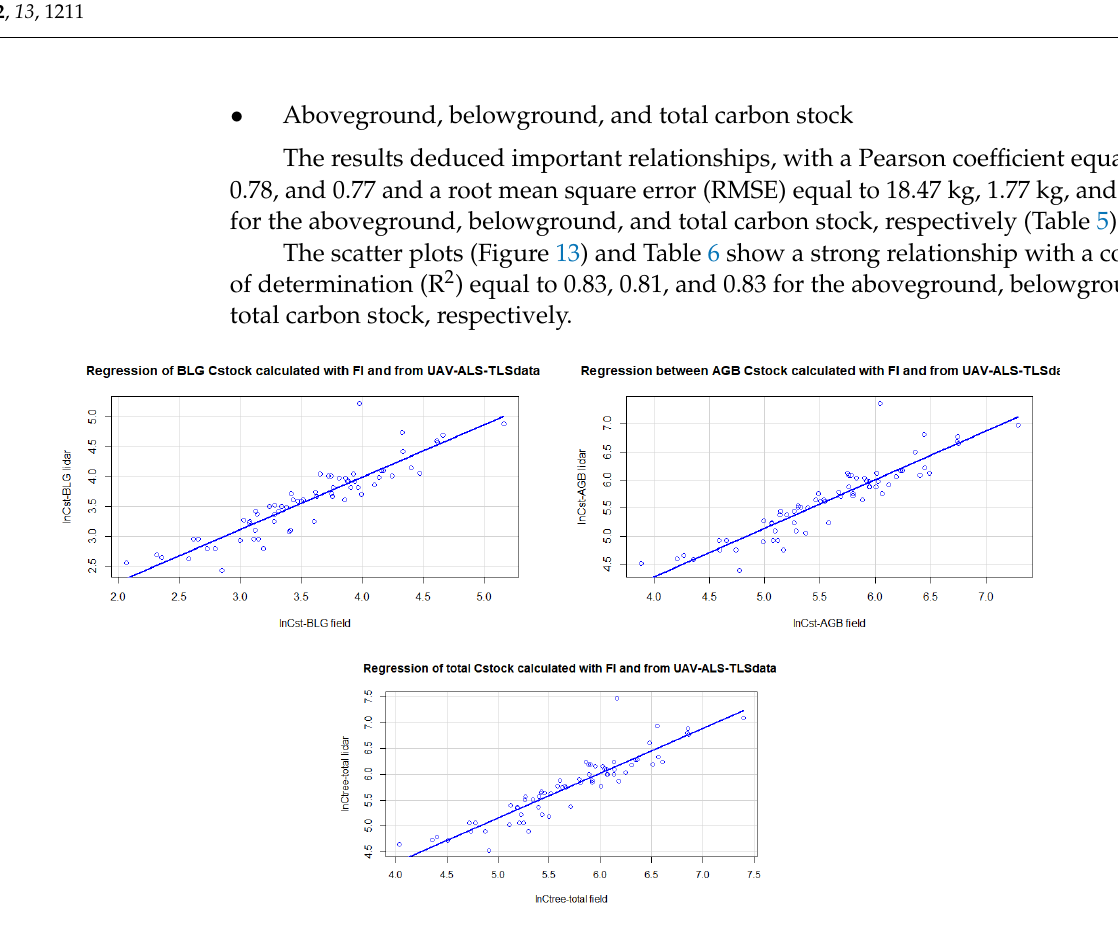
Figure 12. Relationship Representation between aboveground, belowground, and total biomass calculated with two types of inputs (forest parameters from field measurements and those ex-